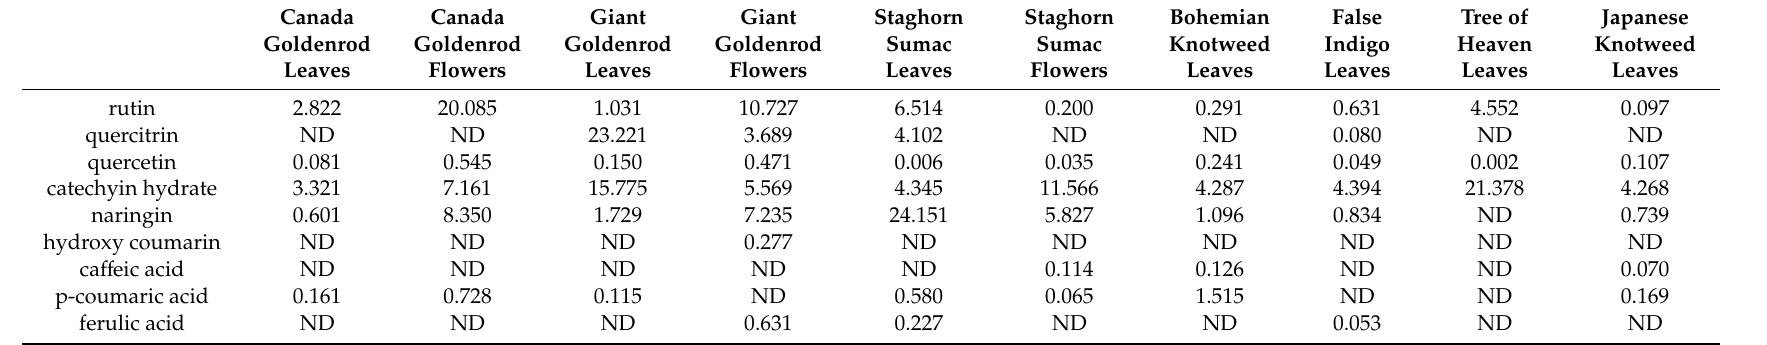
Table 3. Average value of polyphenols (mg /